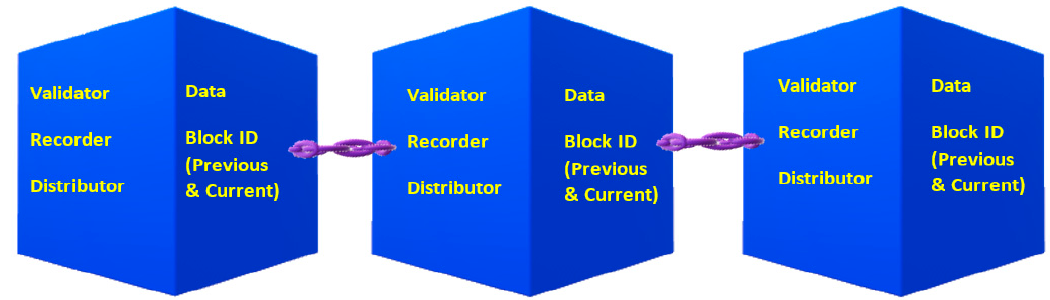
Figure 1. Basic concept of blockchain.